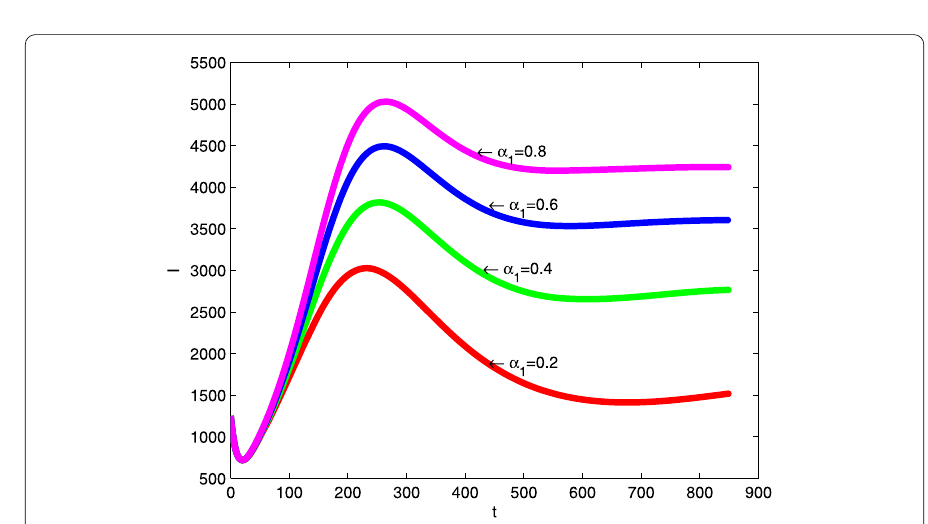
Figure 3 Time series plot of infectious tree population with different replanting